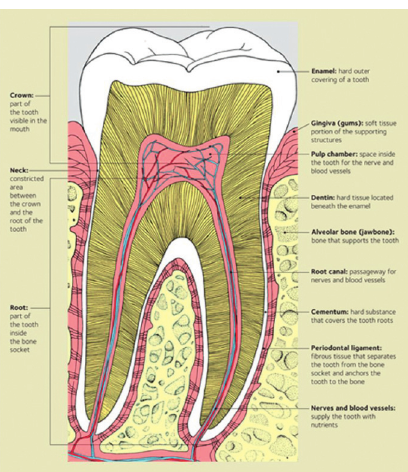
Figure 1: Cross section of a molar tooth [2].